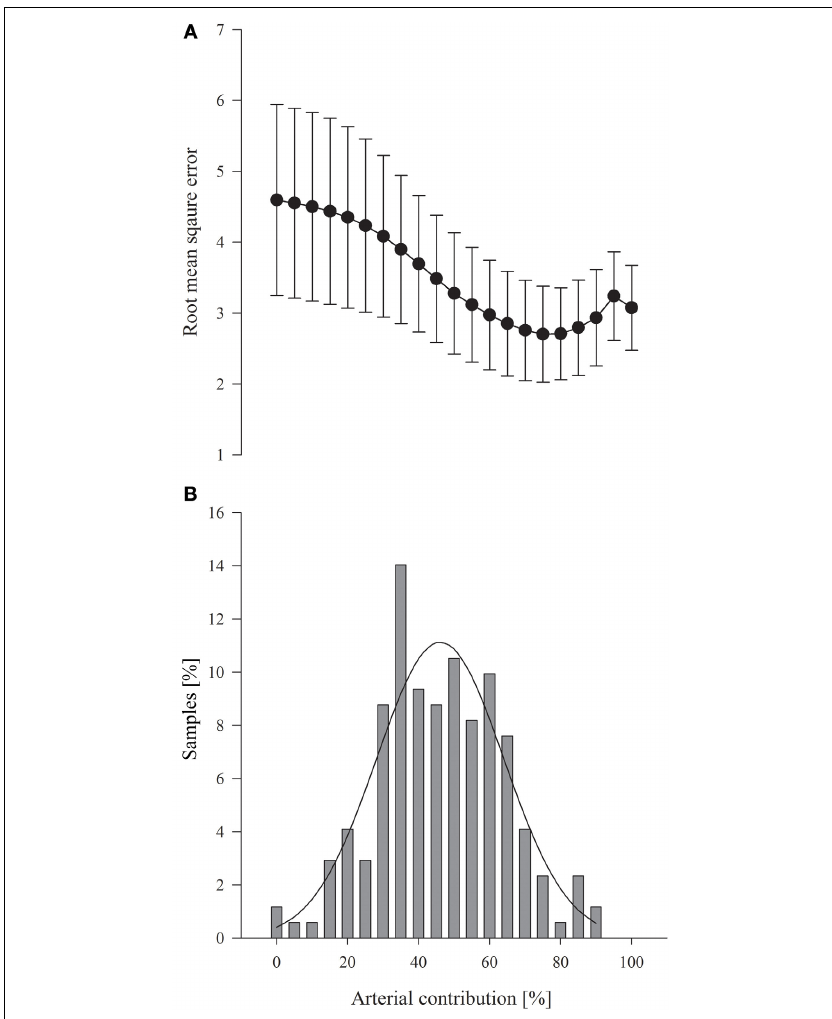
FIGURE 1 | (A) Root mean square error for the arterial fraction determined by the linear regression analysis. Values are mean (95% confidence interval). (B) Zero difference between the Invos-determined cerebral oxygenation (S c O 2 ) and the calculated reference saturation related to the considered arterial contribution for 171 blood samples; average arterial contribution 46 ± 17% ( SD ). Solid line represents the